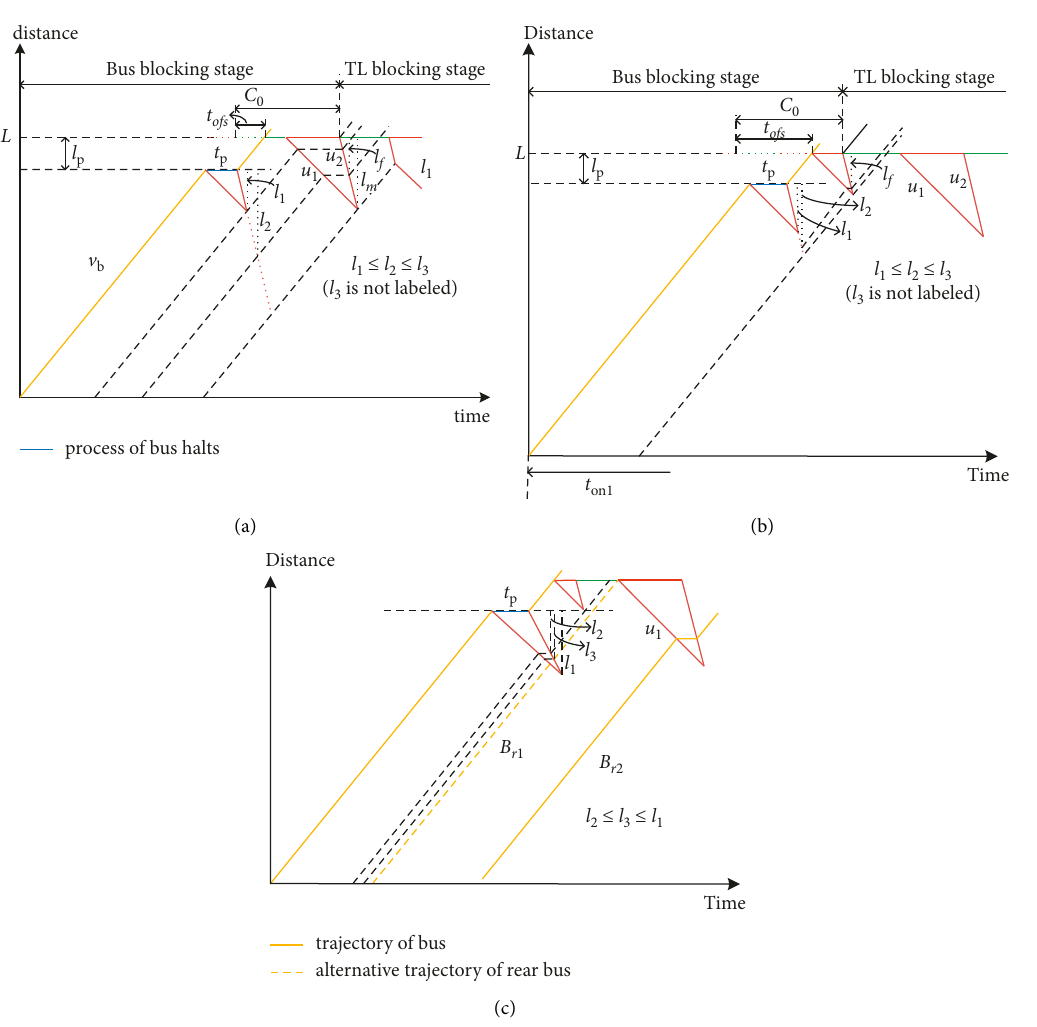
Figure 3: Time-space diagram of three possible evolution processes of the bus blocking stage with near-side bus stop and different arrival signal. (a) Evolution process of bus blocking stage with green arrival signal (0